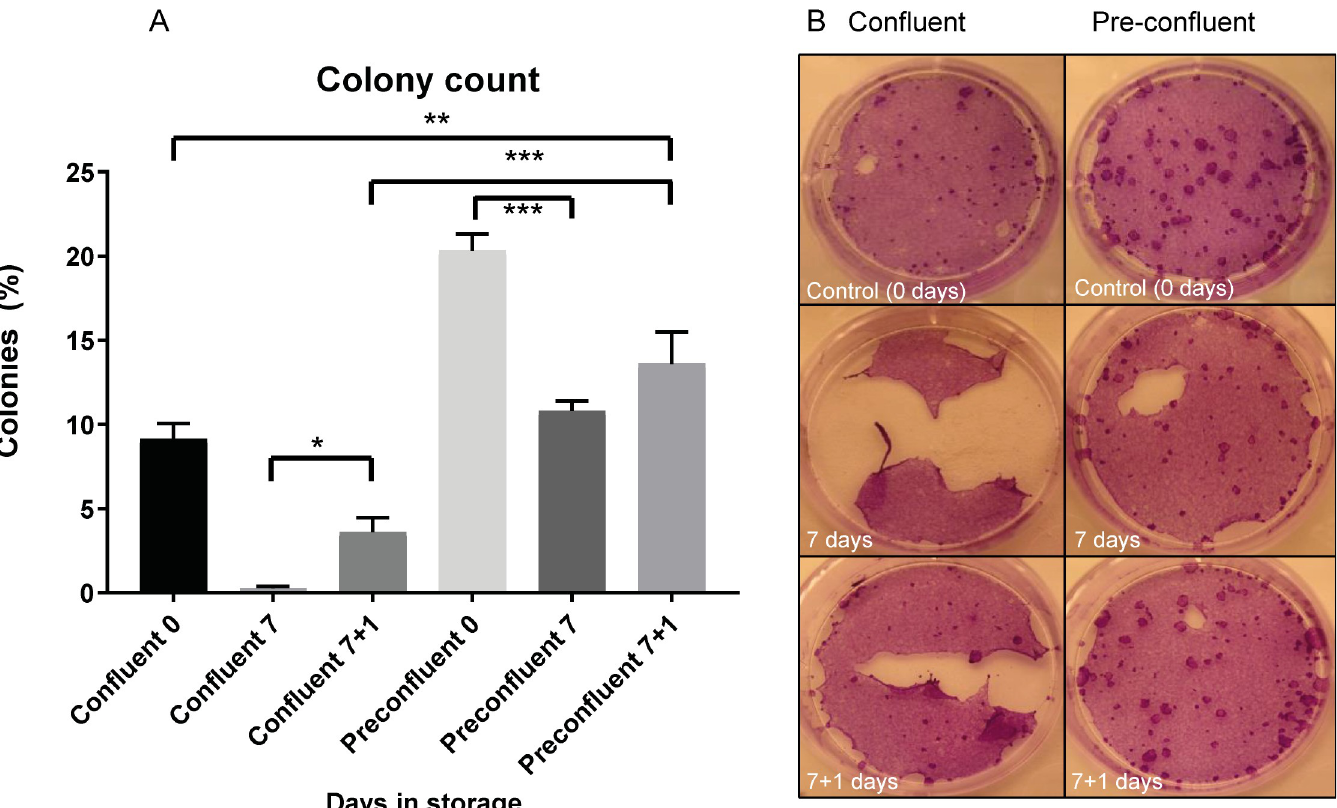
Fig 7. Colony Forming Efficiency (CFE) assay of pre-confluent and confluent cells stored for 7 days with and without one day re-incubation. (A) Counts of colonies in pre-confluent groups compared to confluent groups ( � = significant increase; p = 0.020; �� = significant increase; p = 0.0023; ��� = significant difference; p < 0.0001; n = 3). (B) Representative images of CFE dishes from each